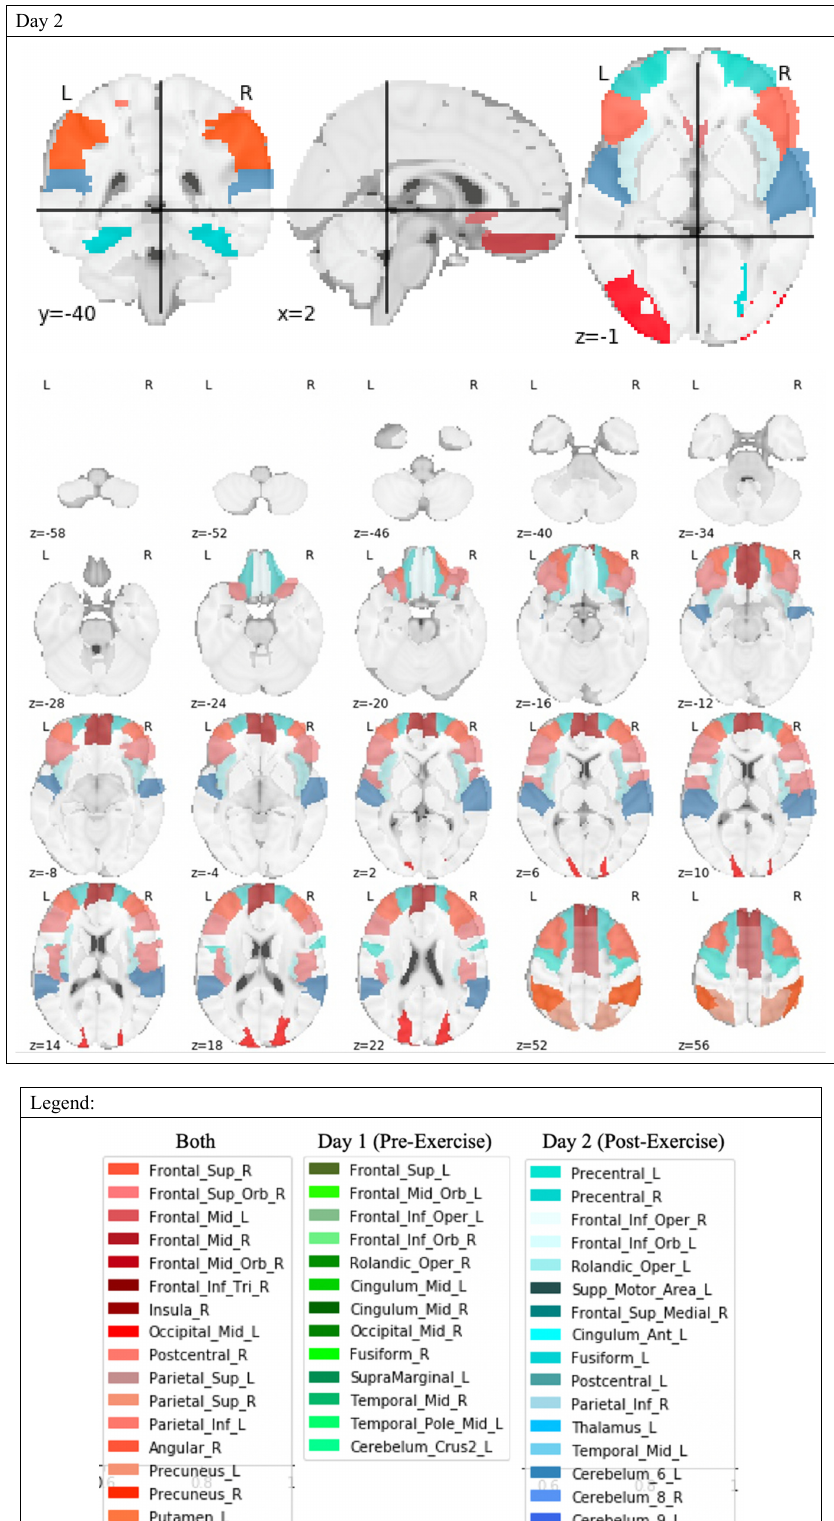
Figure 3. AAL regions selected across Bucket of Models and plotted on the brain for qualitative evaluation. Each of these AAL regions was selected by one or both of the respective Day 1 or Day 2 models based on the training set and validated to achieve the importance metric on the testing set. Features were first automatically selected by the algorithms and then manually reviewed for coefficients and feature importance. Features that had a Random Forest Importance of “0” were removed on subsequent runs. For the final set of models, any features that had a standard error greater than the importance metric itself were also removed. The final list (Figure 4) is visually displayed in order below.